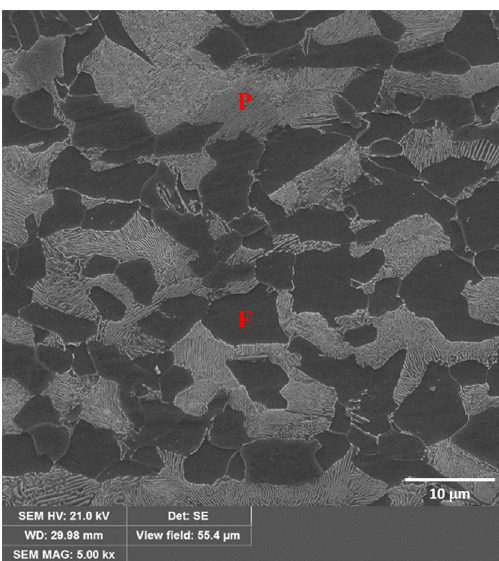
Figure 1. Studied steel microstructure in its as-received condition. F: Ferrite; P: perlite - SEM-5000x - 4% Nital